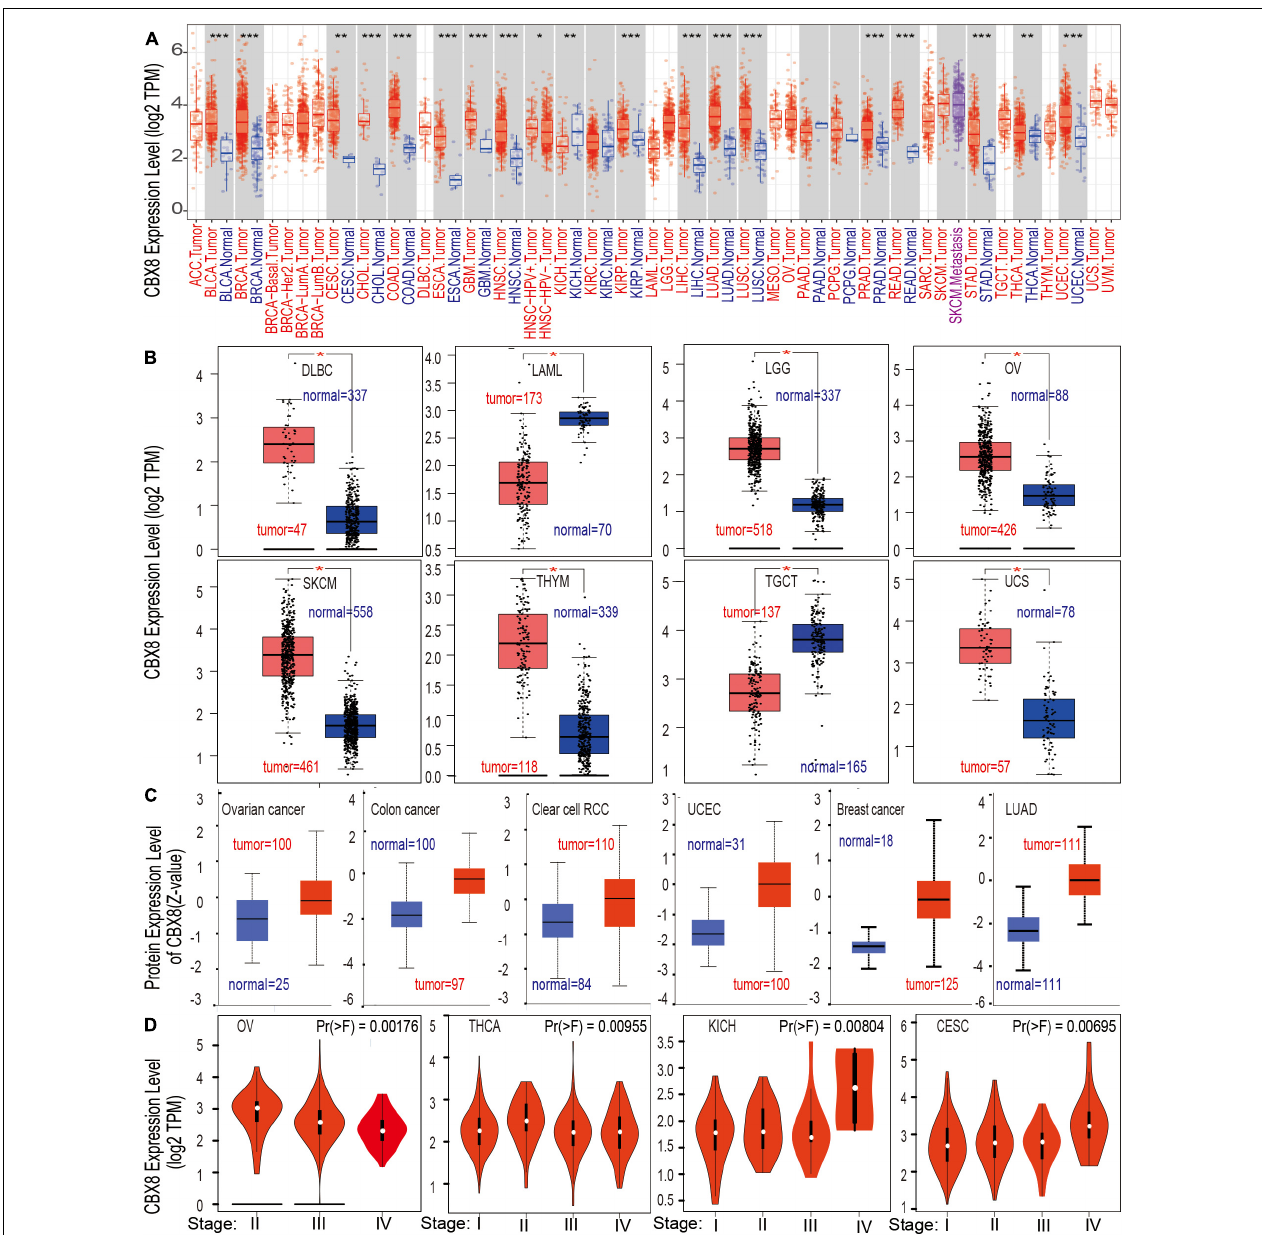
FIGURE 1 | The CBX8 expression level in different tissues. (A) Differences in the expression level of the CBX8 gene (RNA) in different cancers or specific cancer subtypes compared with adjacent normal tissues were analyzed by TIMER2. * P < 0.05; ** P < 0.01; *** P < 0.001. (B) The corresponding normal tissue data for DLBC, LAML, LGG, OV, SKCM, TGCT, THYM, and UCS were provided by the GTEx database as controls to detect CBX8 expression (RNA) level differences, * P < 0.01. (C) Differences in the expression levels between normal tissues and primary tissues from breast cancer, colon cancer, clear cell RCC, lung adenocarcinoma, ovarian cancer, and UCEC were compared using the CPTAC dataset, all P < 0.001. (D) Differences in the expression level of CBX8 (RNA) were analyzed by different pathological stages (stage I, stage II, stage III, and stage IV) of CESC, KICH, OV, and THCA using TCGA data.